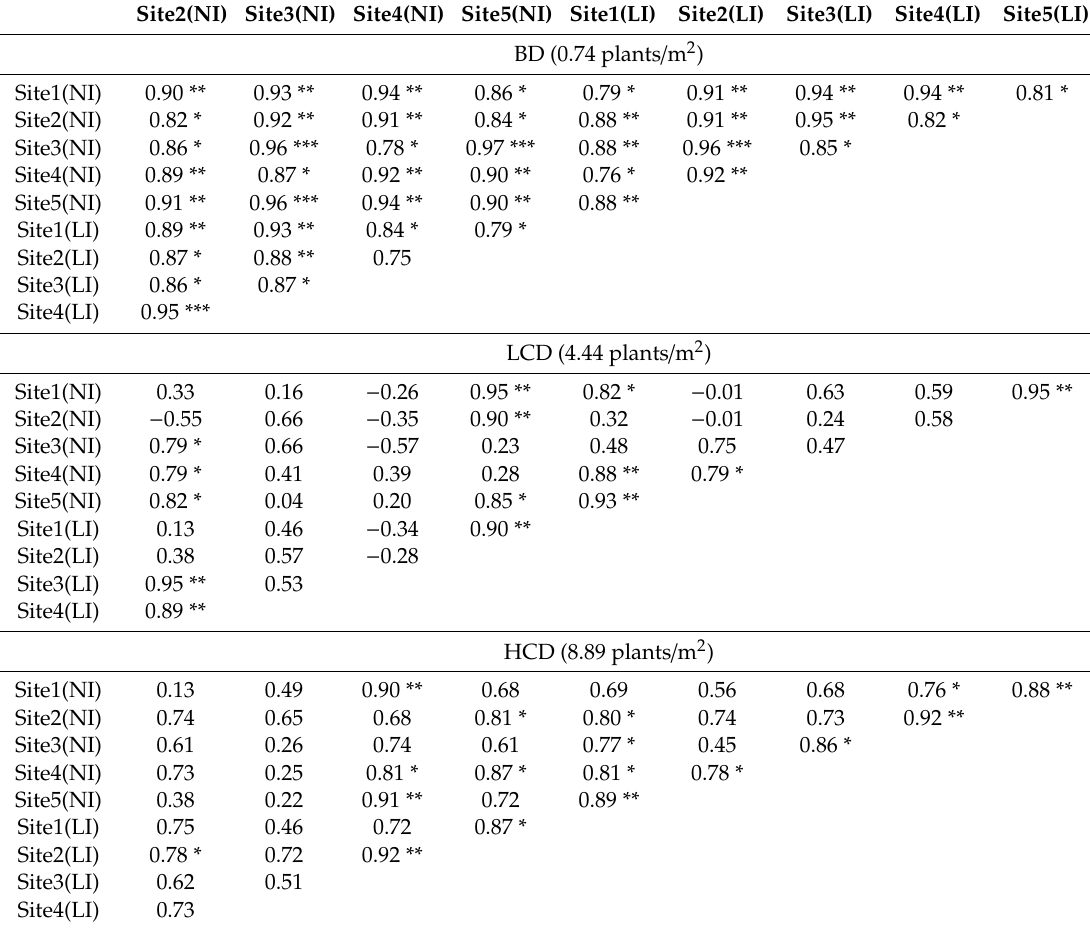
Table 3. Simple correlation coe ffi cients among the ten environments (five sites at the normal irrigation regime, (NI), and the low irrigation regime, (LI), for grain yield of seven hybrids at the breeding density (BD), the low crop density (LCD), and the high crop density (HCD).